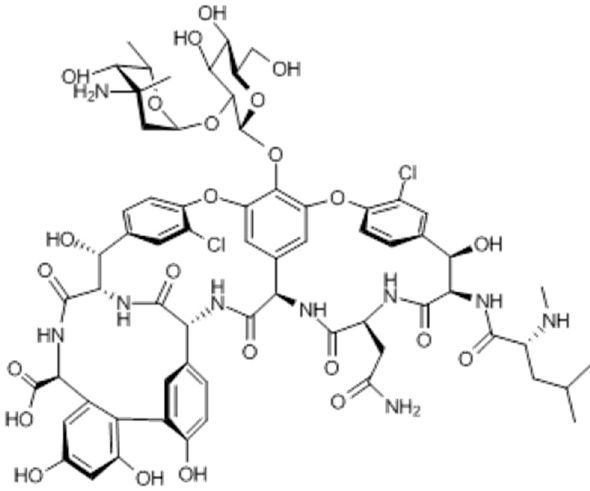
Figure 1. Chemical structure of vancomycin [12].